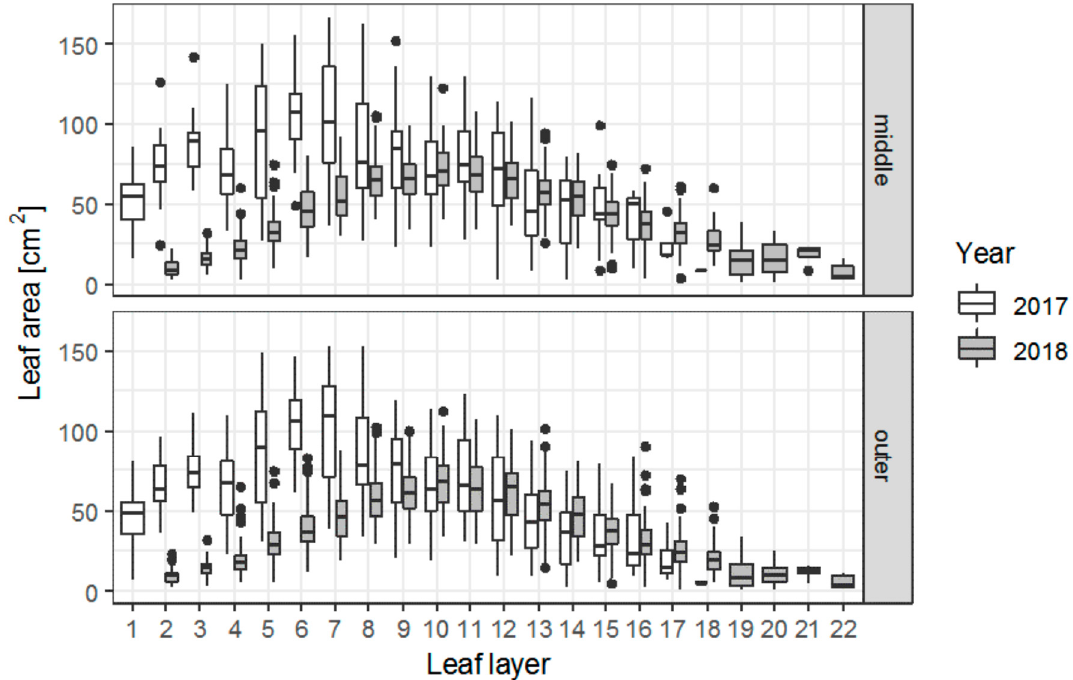
Figure 5. Middle and outer leaflet areas in different leaf levels of soybean during flowering through two growing seasons of 2016 and